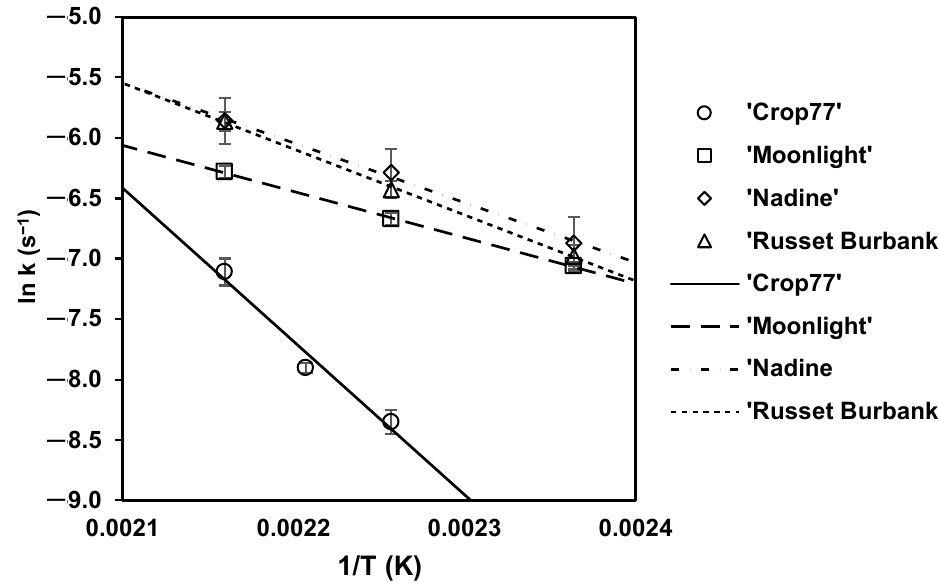
Figure 2. Arrhenius plot of the natural logarithm of k values for changes in L * during frying against the reciprocal of absolute frying temperature for ‘Crop77’, ‘Moonlight’, ‘Nadine’ and ‘Russet Burbank’ subjected to blanching pre-treatment only. Symbols represent the estimated k values for L * from first-order reaction (Equation (3)) and the standard error bars represent the standard deviation (average from three independent frying experiments where each experiment involved a batch of 8–10 potatoes).